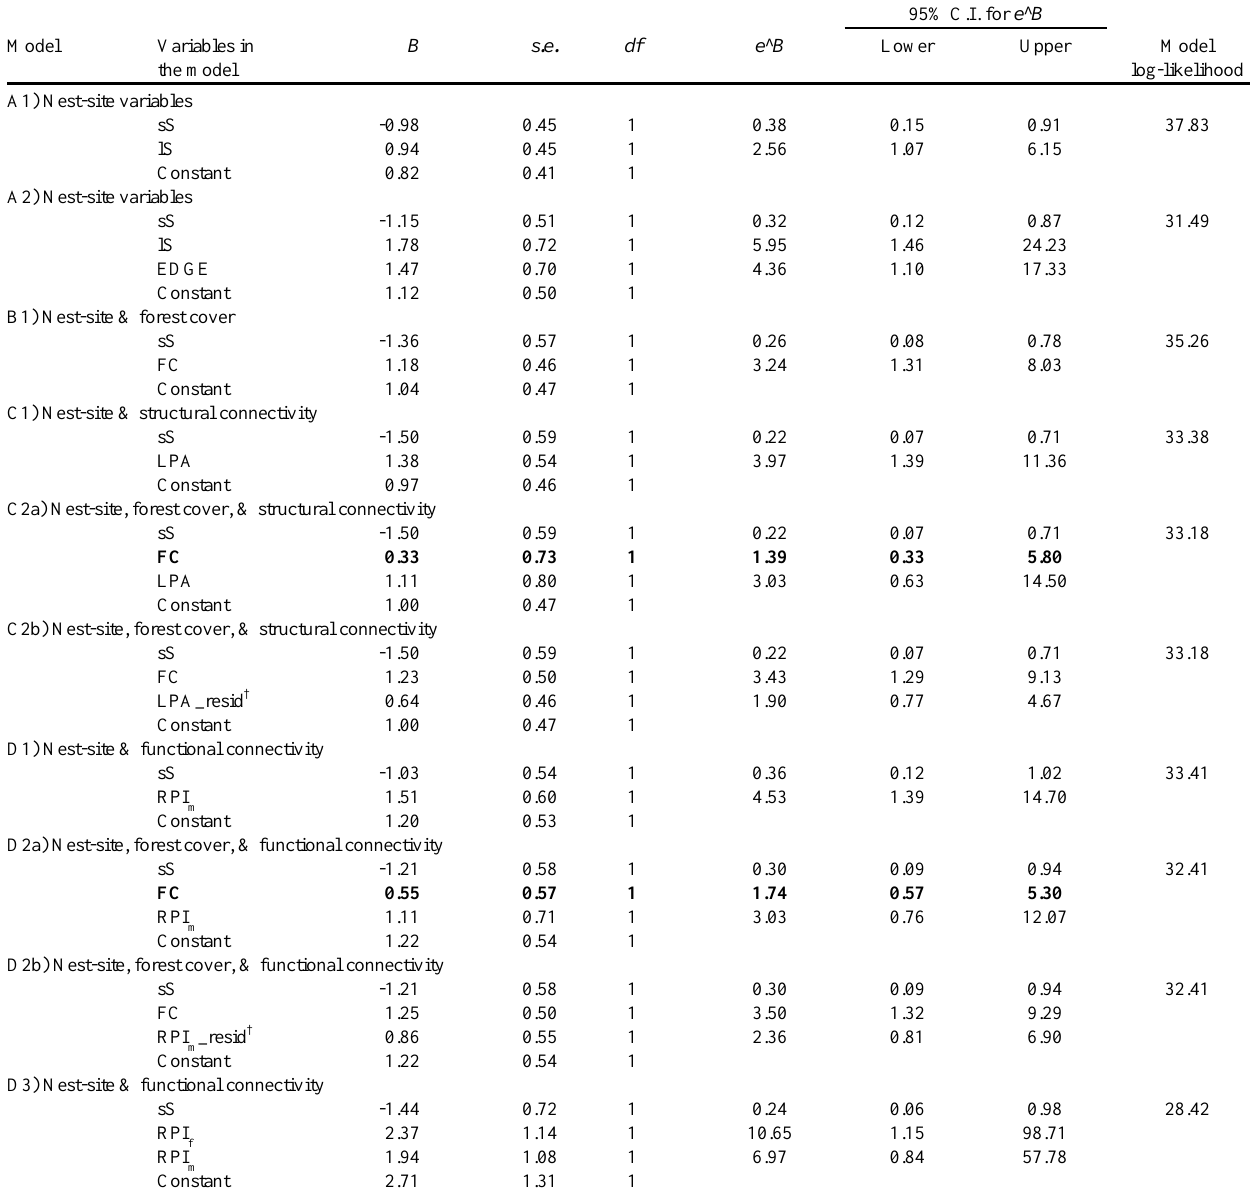
Table 2 . Logistic regression models for S. citrina nest occurrence in 2004 ( n = 38) using standardized nest-site variables, forest cover, and structural OR functional connectivity measures. The odds ratio in logistic regression (e^B) is the exponent of a parameter estimate and this provides an indication of effect size when variables are standardized. Generally odds ratios can be interpreted as the increase (or decrease) in the likelihood of (nest) occurrence with a one unit change in the predictor variable. Variable codes and transformations are described in Table